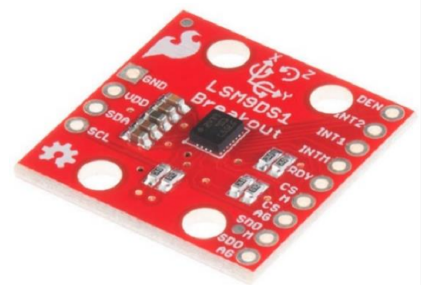
Figure 19. SparkFun LSM9DS1 (Breakout